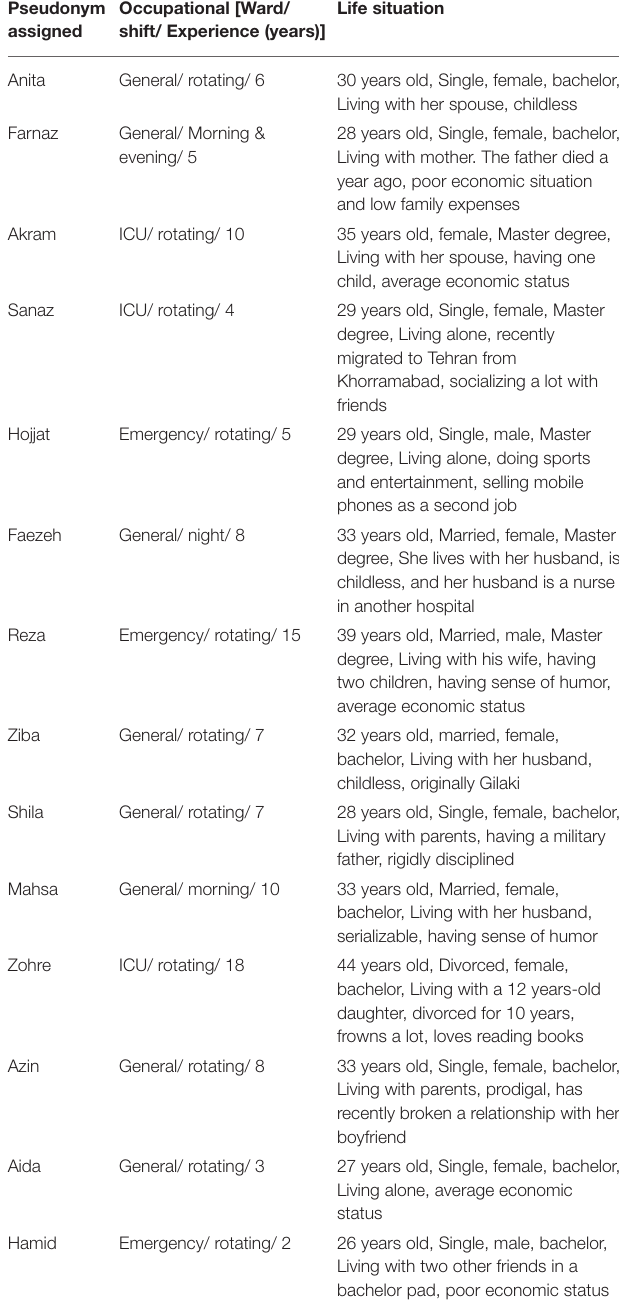
TABLE 1 | Demographic information of participants in the research. Pseudonym